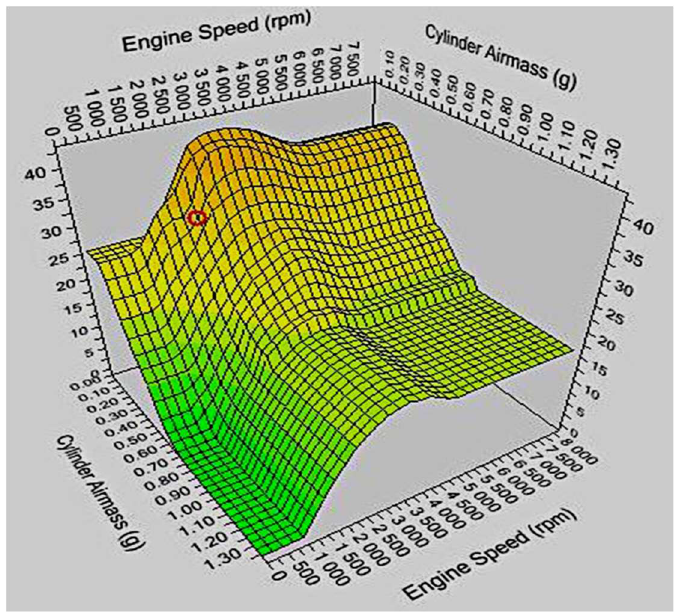
Figure 4. Dependence of the advance ignition angle on speed and fuel supply per